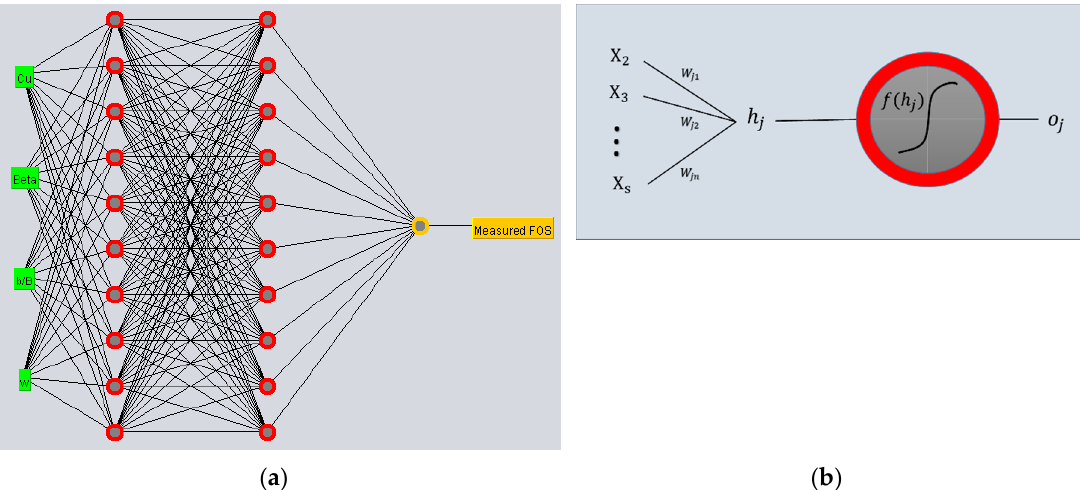
Figure 5. The schematic view of ( a ) the proposed model for the multilayer perceptron and ( b ) the operation of computational neurons.